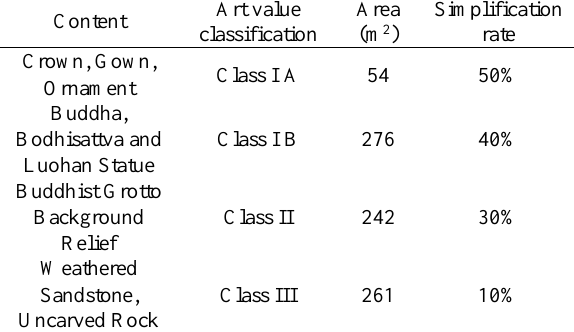
Table 2 Surface art value classification statistical table